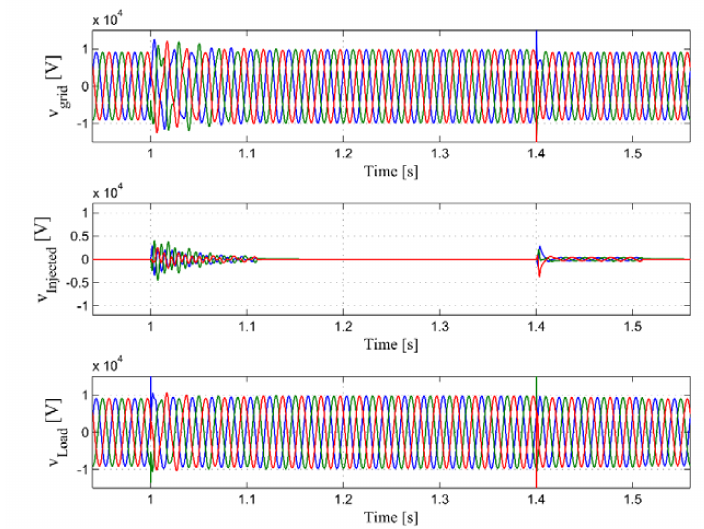
Figure 17. Case 6-Fluctuations and distortions voltages: grid voltage, injected voltage of the DVR and load voltage. The sinusoidal waveforms obtained two cycles after the disturbance occurs.